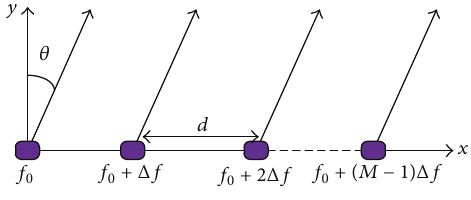
Figure 2: The FDA